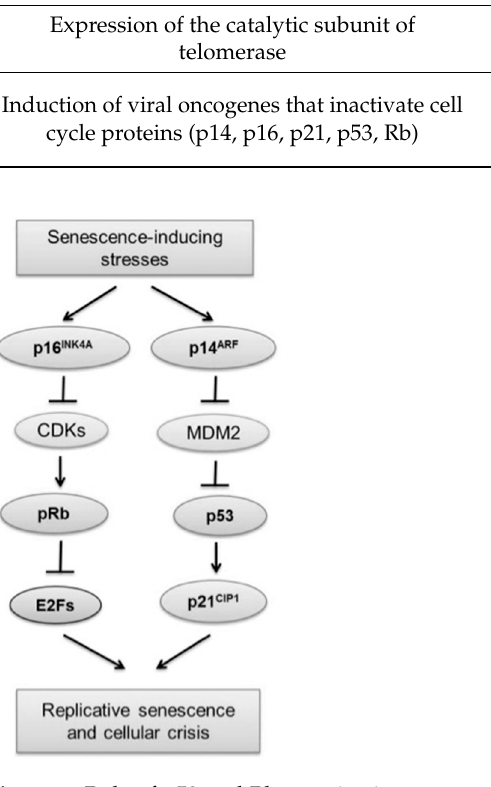
Figure 4. Role of p53 and Rb proteins in senescence and immortalization. Reprinted with modifica-